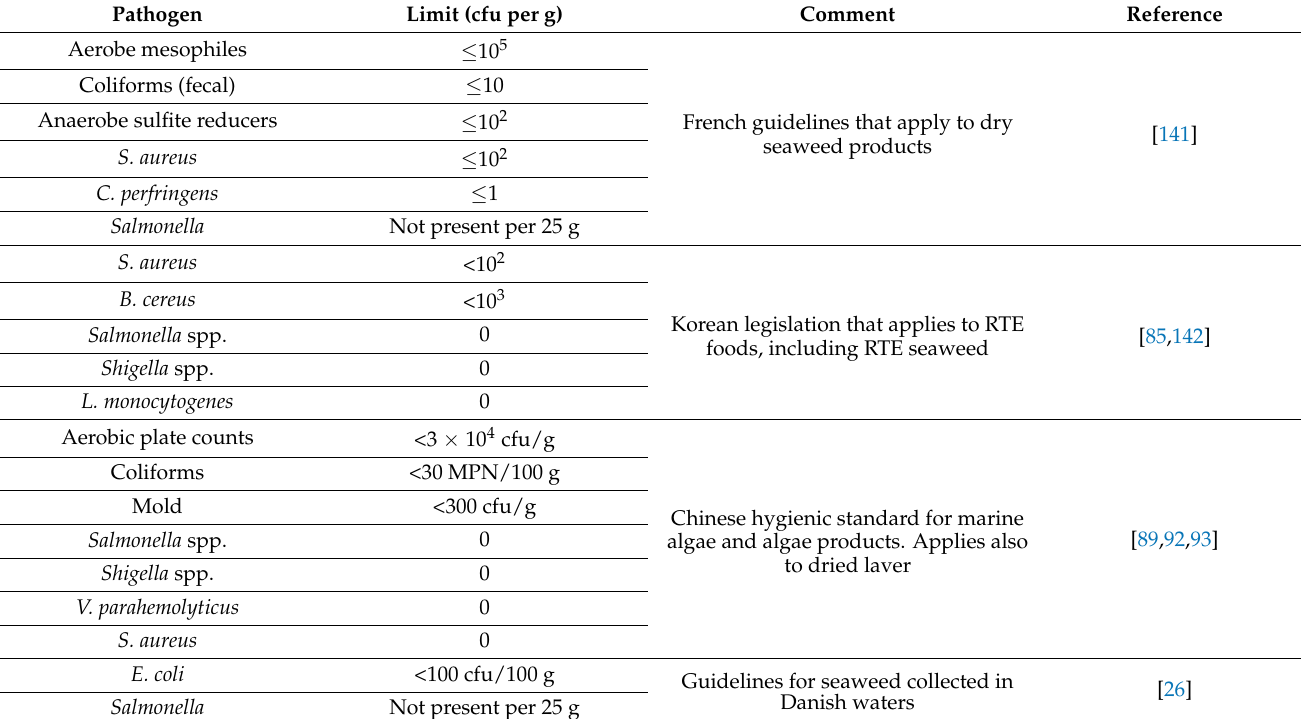
Table 3. Selected standards for microbial load in seaweed food